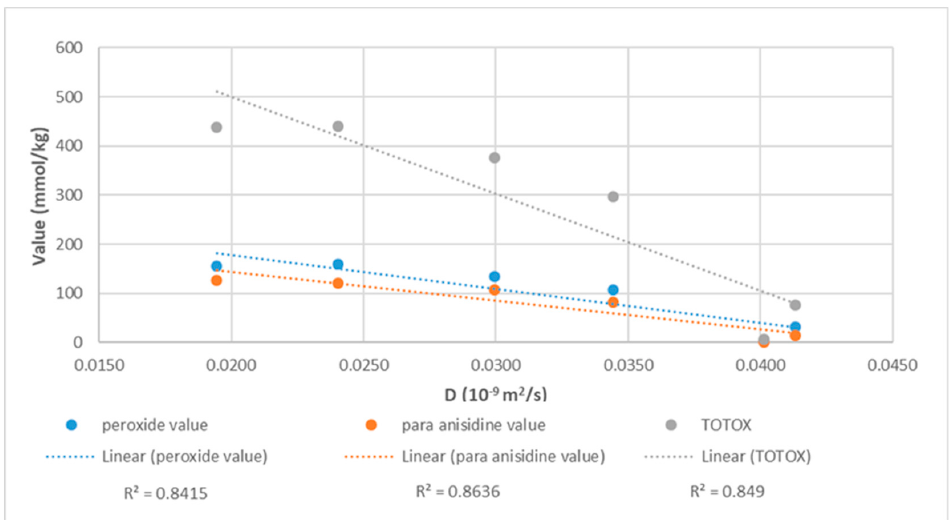
Figure 2. Correlation between linseed oil self-diffusion (D) and PV/AV/TOTOX. Averages of 38 analyses for each point taken from the database (S1) were used.